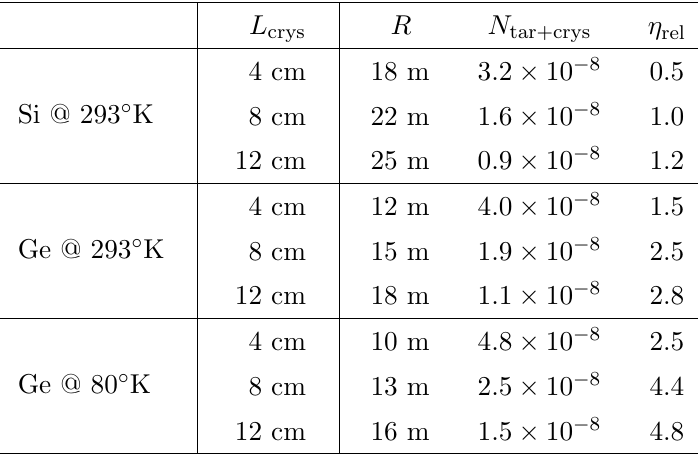
Table 3 . Optimal crystal